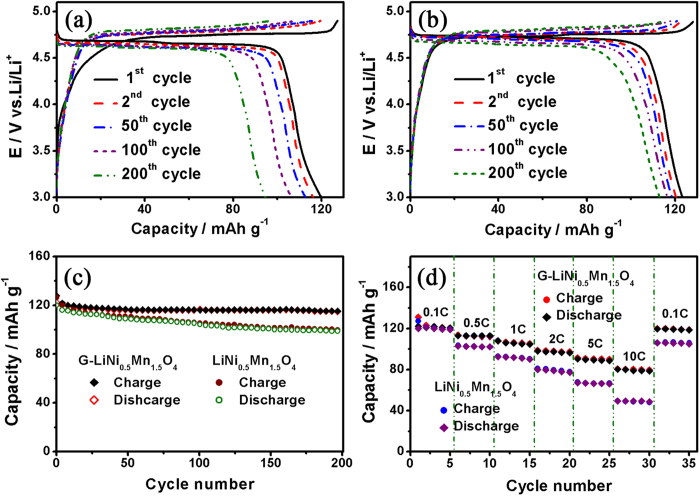
(a) Charge/discharge curves of the bare LiNi0.5Mn1.5O4 nanorod electrode at various cycle numbers at 0.1 C rate. (b) Charge/discharge curves of the LiNi0.5Mn1.5O4-graphene composite electrode at various cycle numbers at 0.1 C rate. (c) Comparison of cycle performance between the bare LiNi0.5Mn1.5O4 nanorod electrode and the LiNi0.5Mn1.5O4-graphene composite electrode. (d) Comparison of rate capability between the bare LiNi0.5Mn1.5O4 nanorod electrode and the LiNi0.5Mn1.5O4-graphene composite electrode.